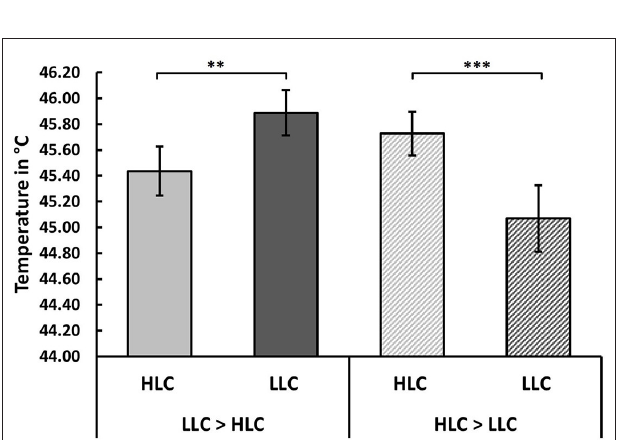
FIGURE 3 | Effect of cognitive load on pain thresholds. Participants could be subdivided into two subgroups, showing distinct responses to the high load task (HLC). About half of all participants (51.1%) showed an increased pain threshold in the HLC relative to the LLC, whereas the remaining 48.9% exhibited a higher pain threshold in the LLC relative to the HLC. Bar charts illustrate the average pain thresholds for both conditions for each subgroup. Error bars represent the standard error of the mean (SEM). ** p < 0.01, *** p <